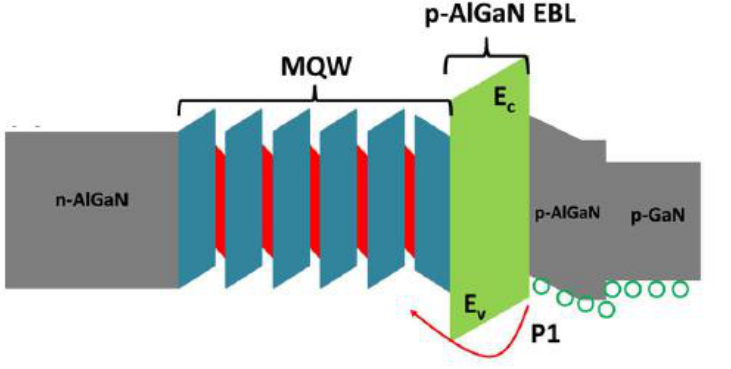
Figure 5. Schematic energy band diagrams and hole injection mechanisms for DUV-LED with conventional p-AlGaN EBL [68].